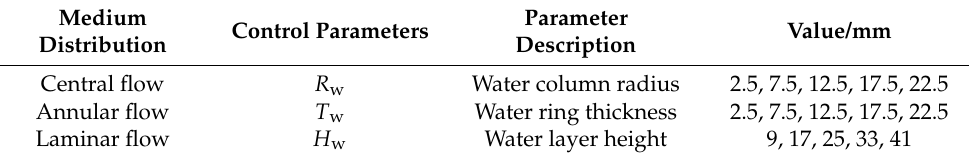
Figure 4. Schematic diagram of simulation object field setting of heterogeneous ECT sensor. Table 3. Setting parameters of non-uniform ECT sensor simulation object